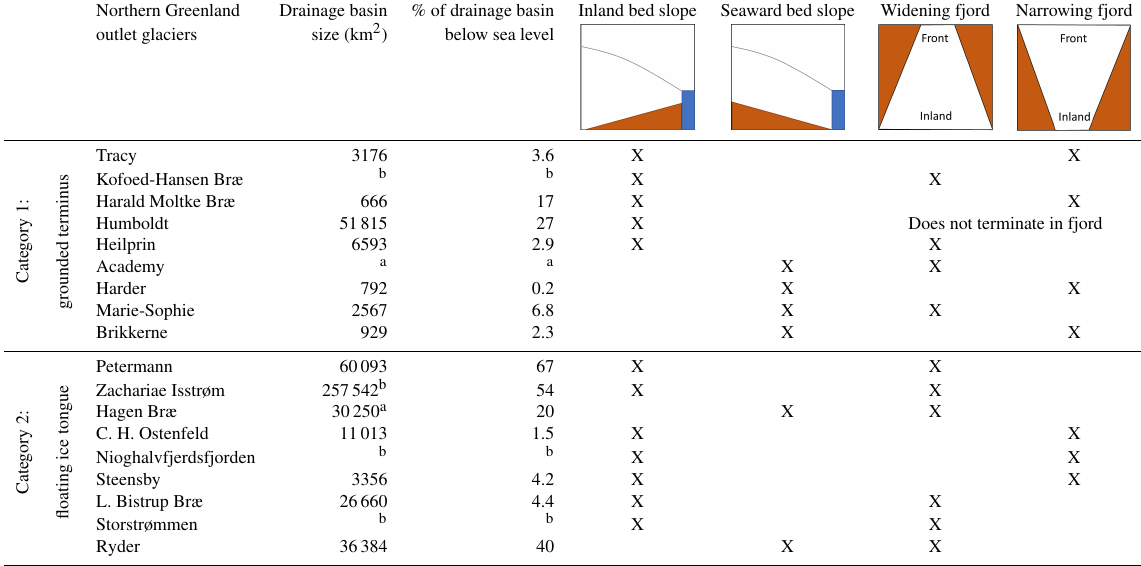
Table 3. Glacier-specific factors at 18 northern Greenland study glaciers. This includes the size and percentage of each surface drainage basin below sea level, the direction of the bed slope 20km inland of the grounding line (inland or seaward), and whether the fjord widens or narrows with distance